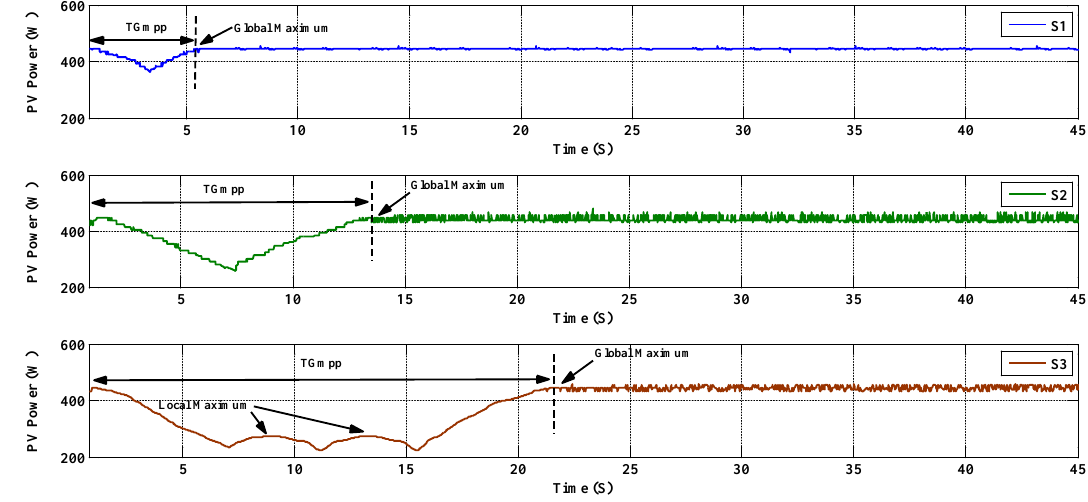
Figure 22. P - V and I - V curves for different scenarios of shading ( a ) the detected GMPP by S1, S2, and S3 and ( b ) the detected GMPP by S1, S2, and S3